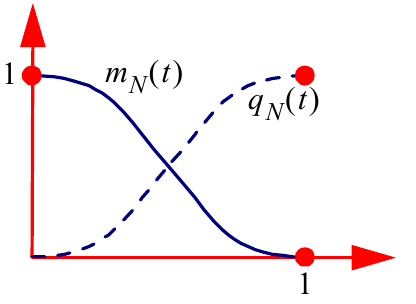
Figure 1. Illustration of the normalized demarcation functions m N ( t ) and q N ( t ) .